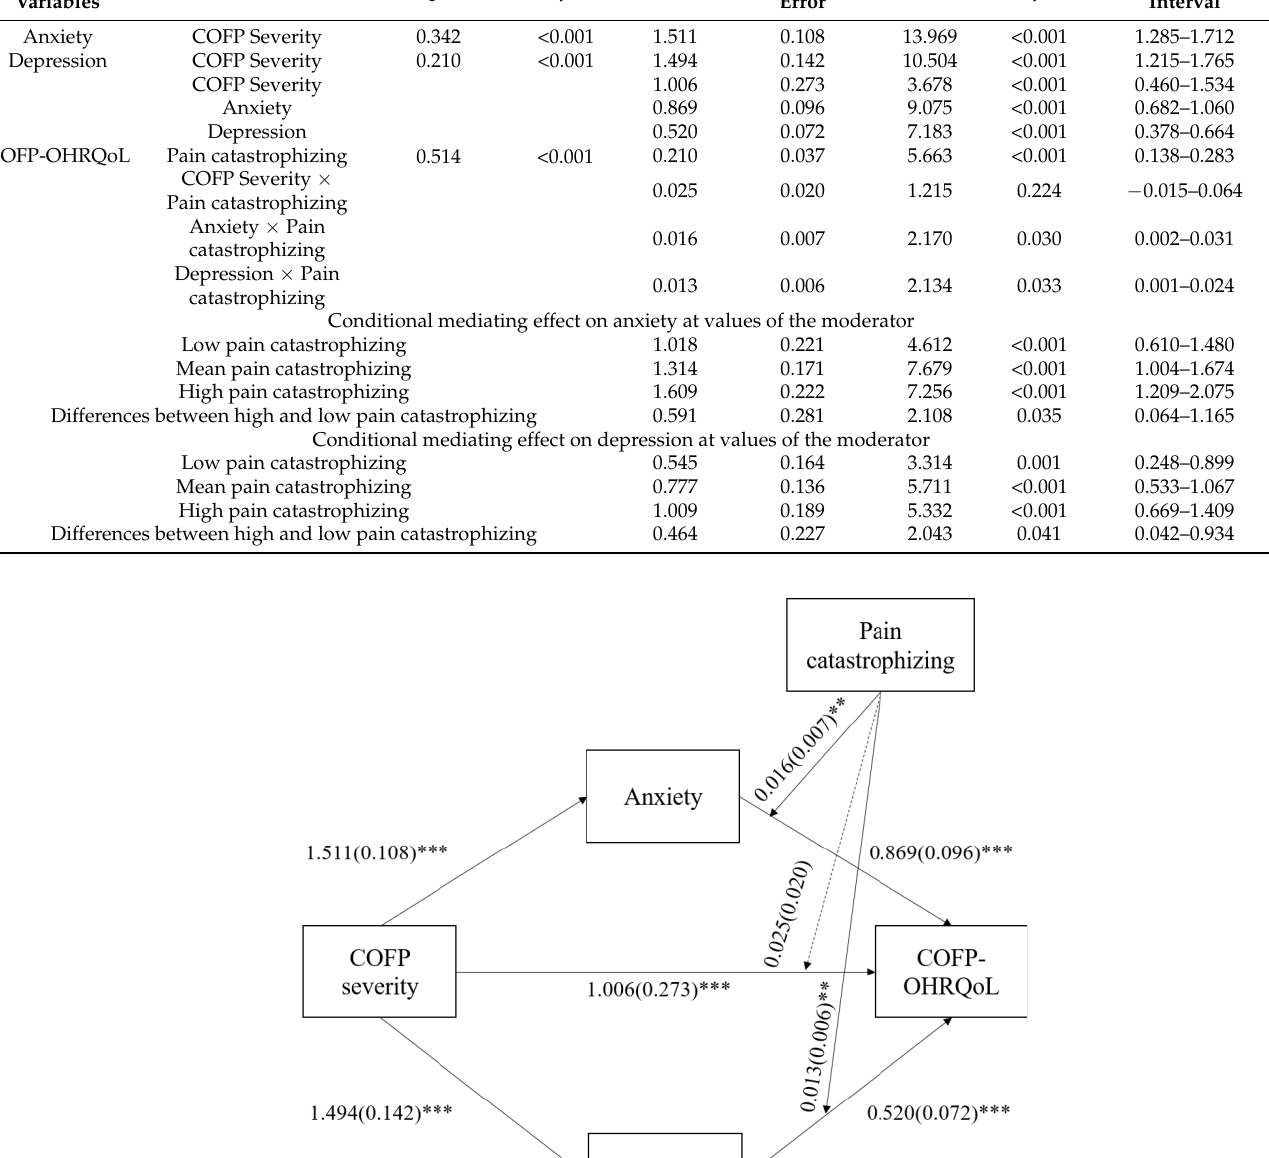
Table 5. The moderating effect test of pain catastrophizing with respect to anxiety and depression. Table 4. The estimates of total, direct, and indirect effects of the model (with anxiety and depression as mediating variables) .